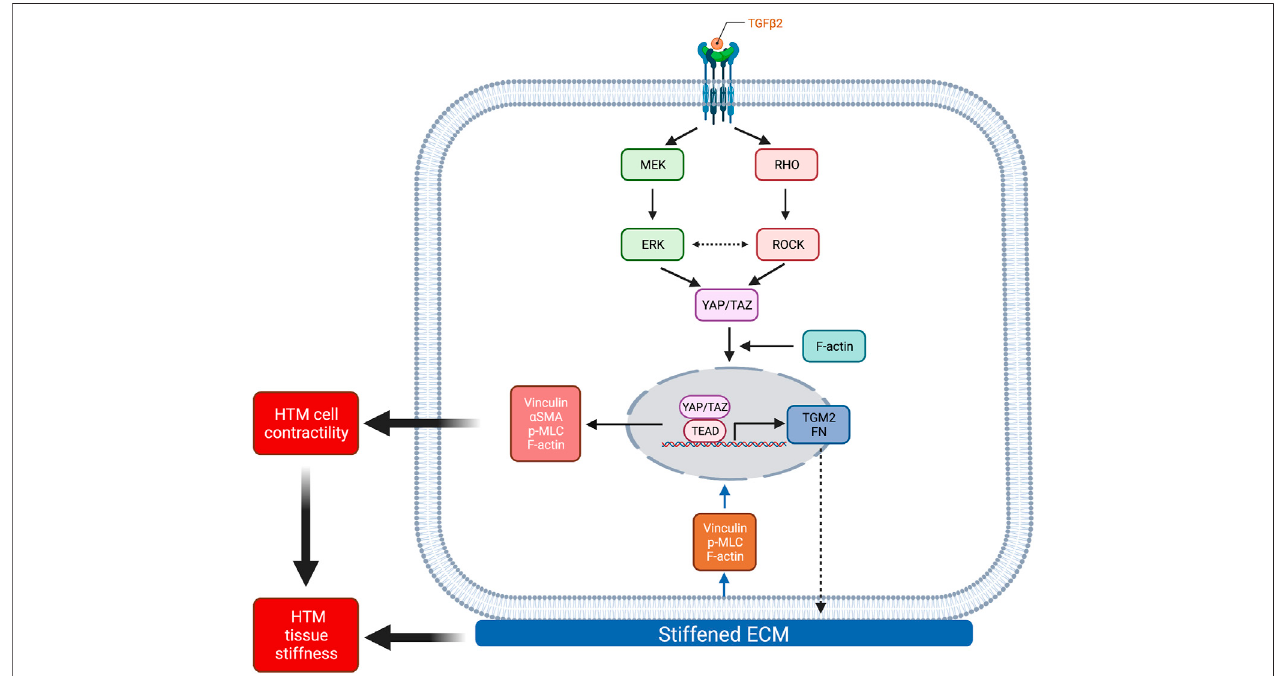
FIGURE8| Schematicillustration oftheeffects elicitedbyECMstiffnessand TGF β 2thatmodulate YAP/TAZactivity inHTMcells. Stiffened ECMhydrogelselevate YAP/TAZ activity potentially through regulating focal adhesion formation and actin cytoskeleton rearrangement. TGF β 2 activates ERK and ROCK signaling pathways, with potential context-dependent crosstalk, to regulate YAP/TAZ activity in normal HTM and GTM cells. YAP/TAZ activation induces HTM cell contractility and ECM remodeling, which together may increase HTM stiffness in POAG. Created with BioRender.com.